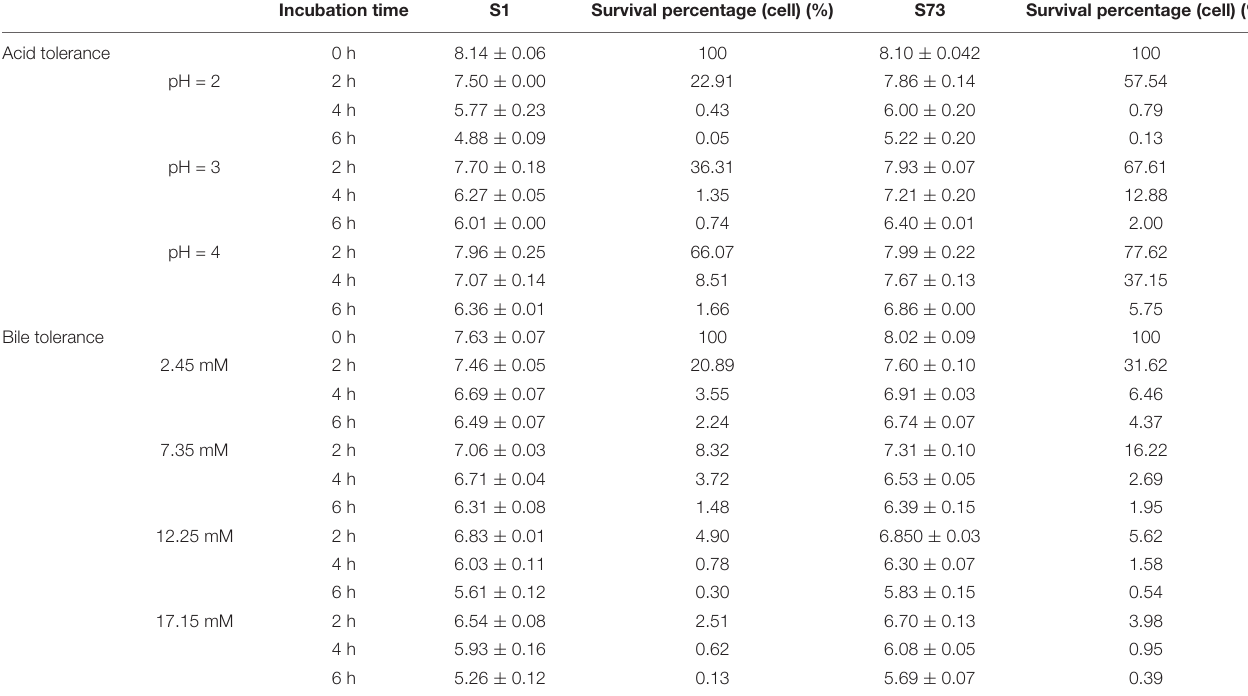
TABLE 4 | Viability of final candidates under acidic conditions or bile challenge (log